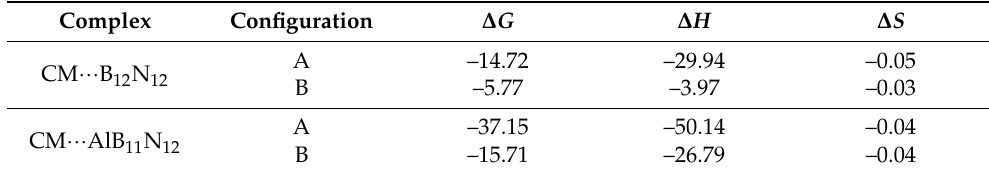
Table 6. Thermodynamic parameters, i.e., Gibbs free energy ( ∆ G ), enthalpy change ( ∆ H ), and